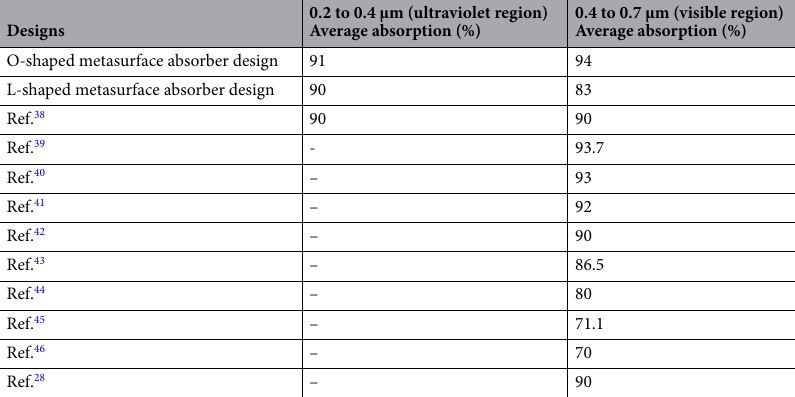
Table 1. Comparison of solar absorber